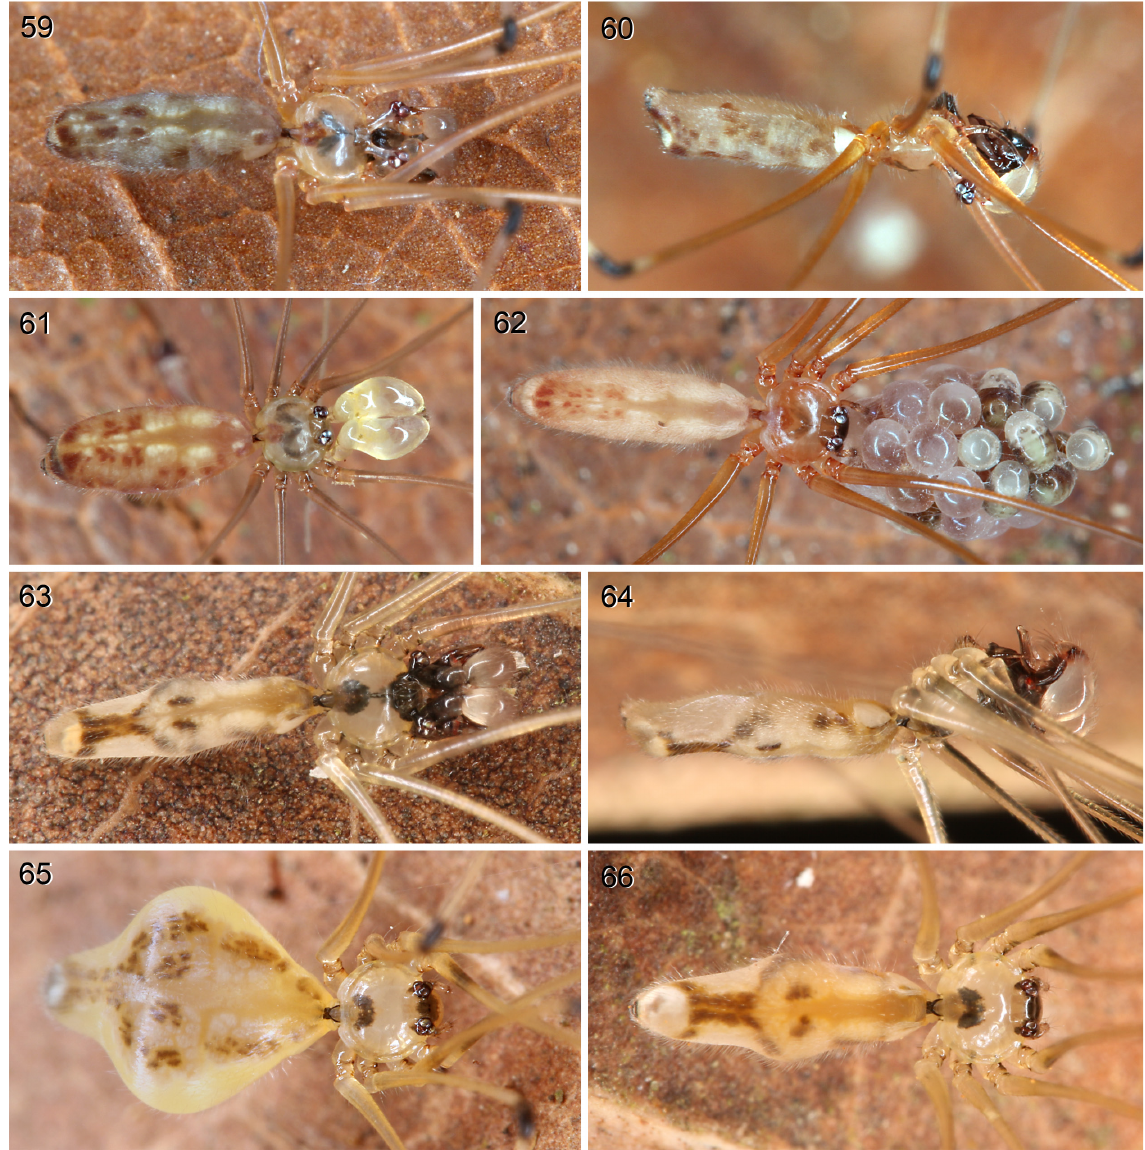
Figs 59–66. Live specimens. 59–62 . Pholcus bukittimah Huber sp. nov., Dairy Farm, ♂, penultimate